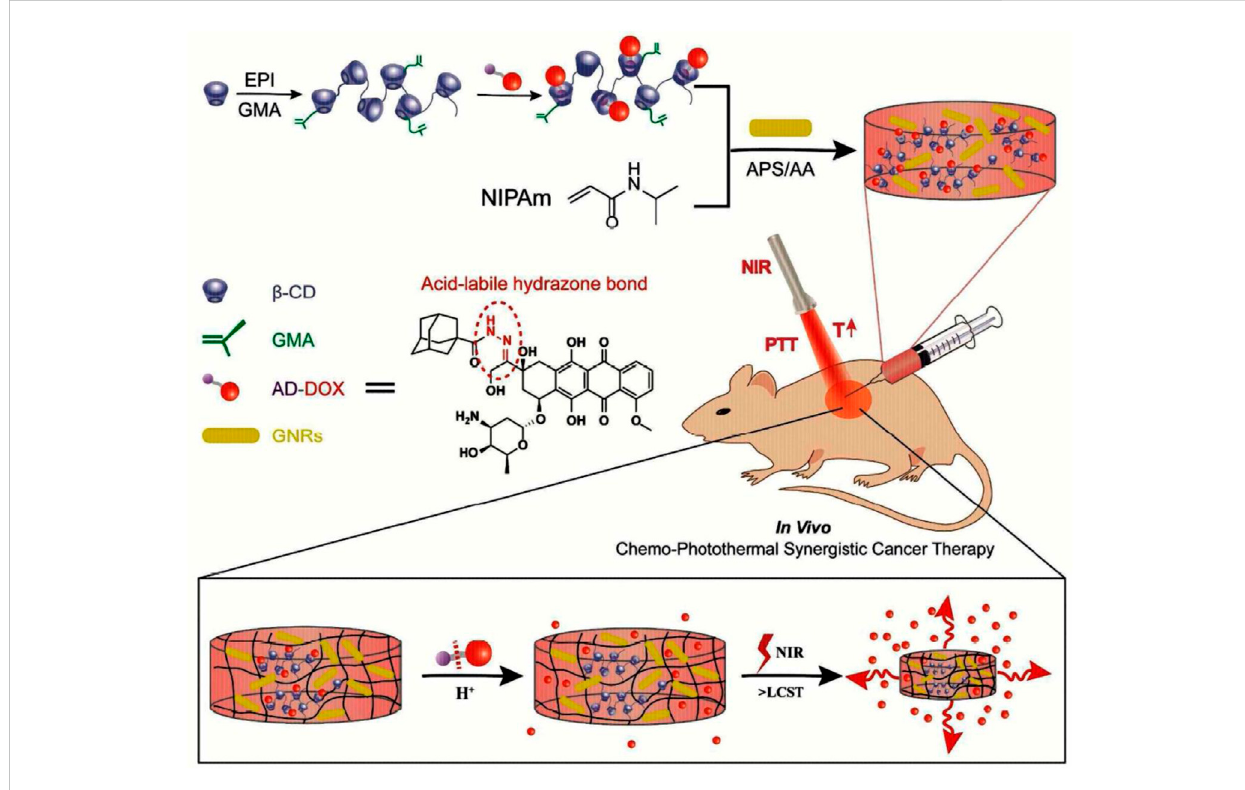
FIGURE 10 Formation of injectable, NIR/pH-responsive nanocomposite hydrogel and chemo-photothermal synergistic cancer therapy. Reprinted with permission from (Xu et al., 2017). Copyright 2017 American Chemical